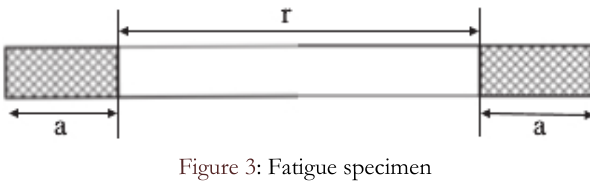
Figure 3: Fatigue specimen